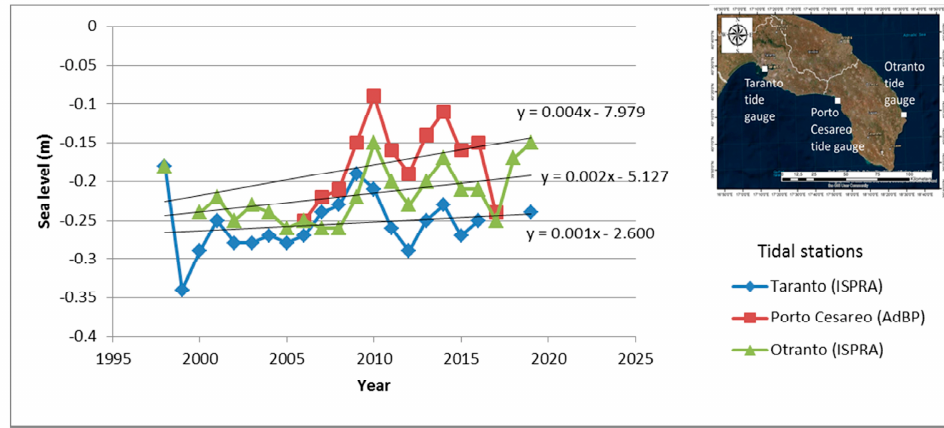
Figure 5. Annual mean sea-level records at the Taranto, Otranto, and Porto Cesareo tidal stations (retrieved from www.mareografico.it [67] and www.adb.puglia.it [68], ISPRA—Istituto Superiore per